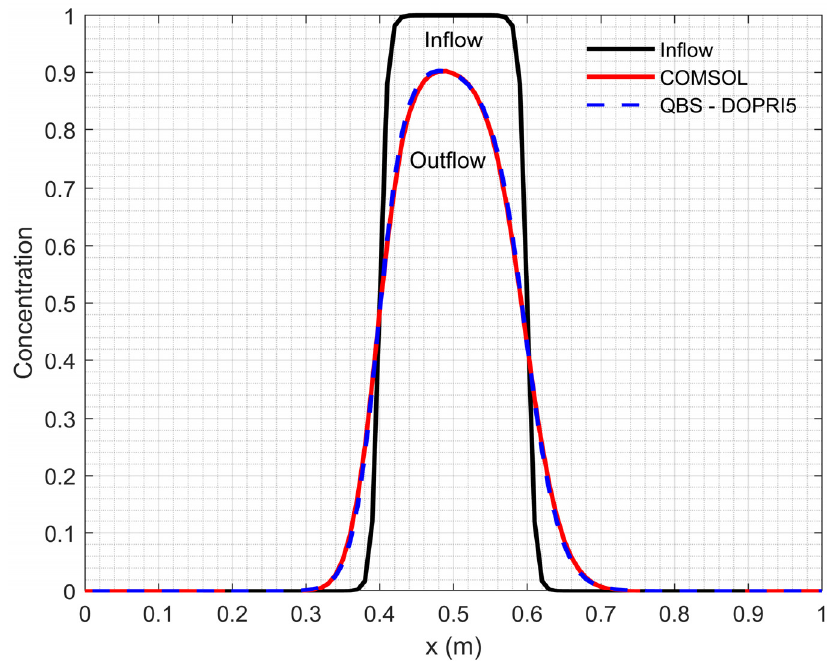
Figure 11. Concentration profiles at the inlet and outlet boundary at time 1.7 days for Scenario B.